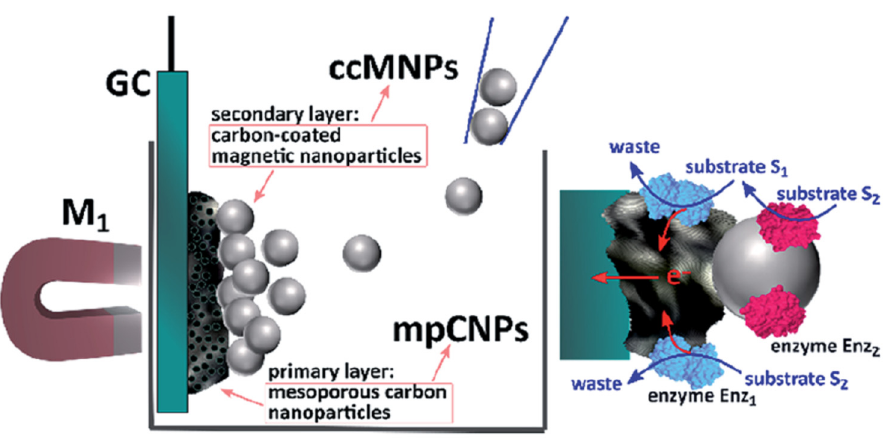
Figure 4. Illustration of the magnetic activation of bioelectrocatalytic cascades through channeling of enzyme-modified magnetic nanoparticles onto the surfaces of enzyme-functionalized mesoporous carbon nanoparticles [57]. Copyright 2019 Royal Society of Chemistry.